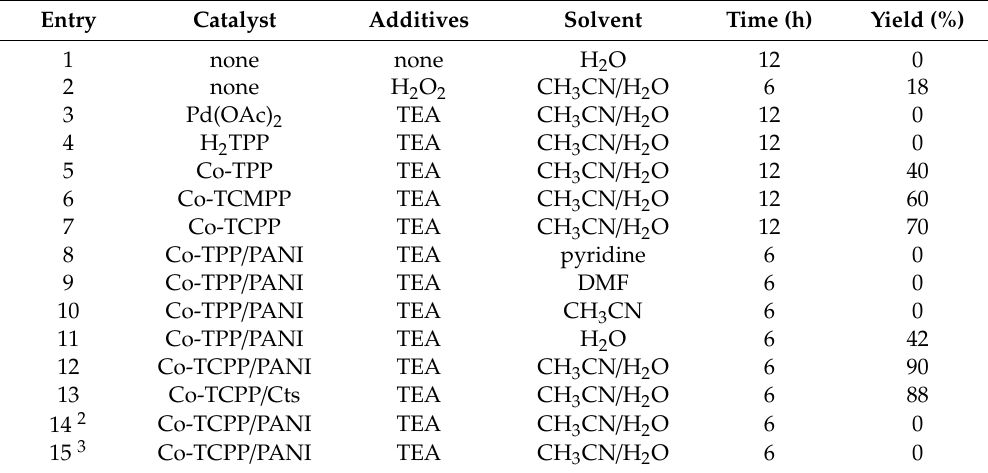
Figure 1. Hydroxylation of phenylboronic acid catalyzed by Co(II)-porphyrins. Table 1. Co-catalyzed hydroxylation of phenylboronic acid under irradiation 1